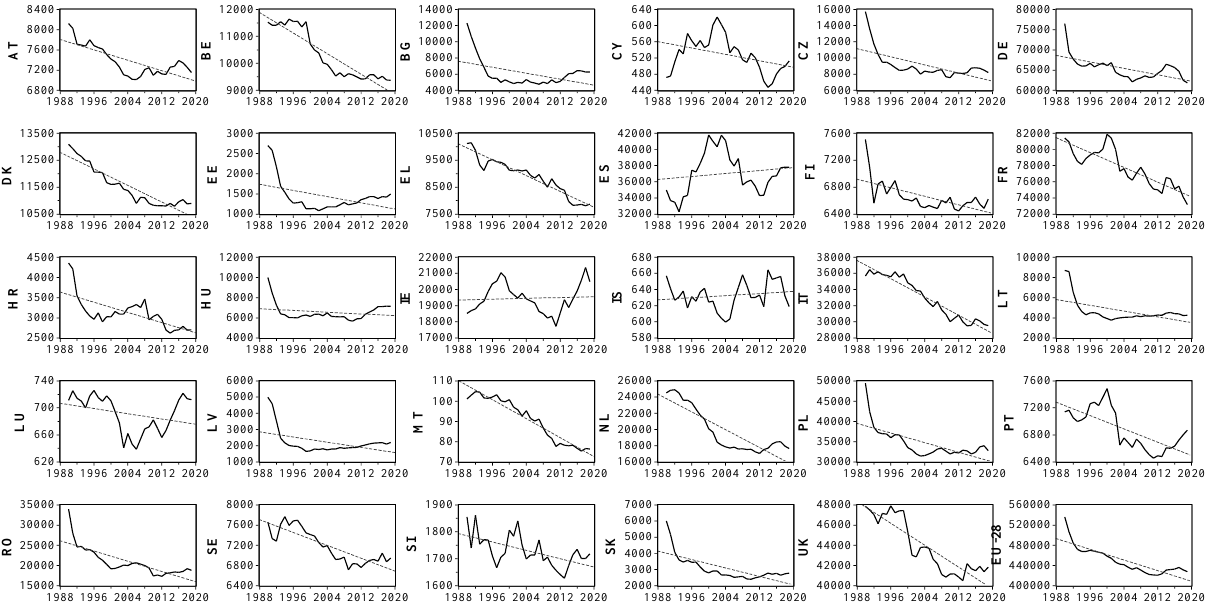
Figure 1. Time evolution of total GHG emissions between 1990 and 2019 from agricultural sector within EU-28.